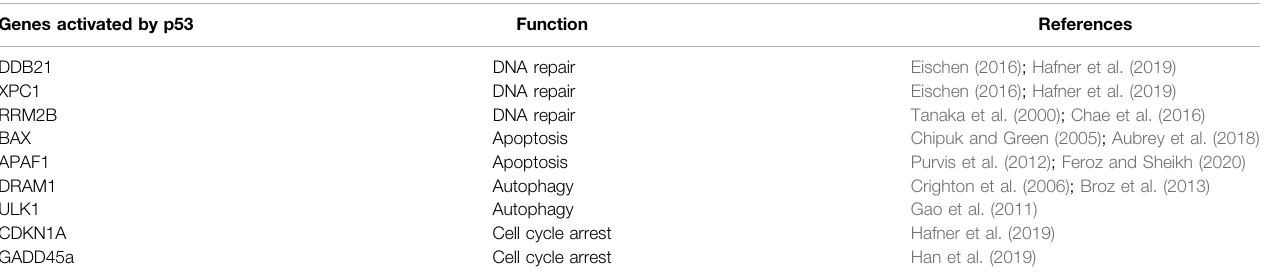
TABLE 1 | Genes transcriptionally activated by p53 and their functions.